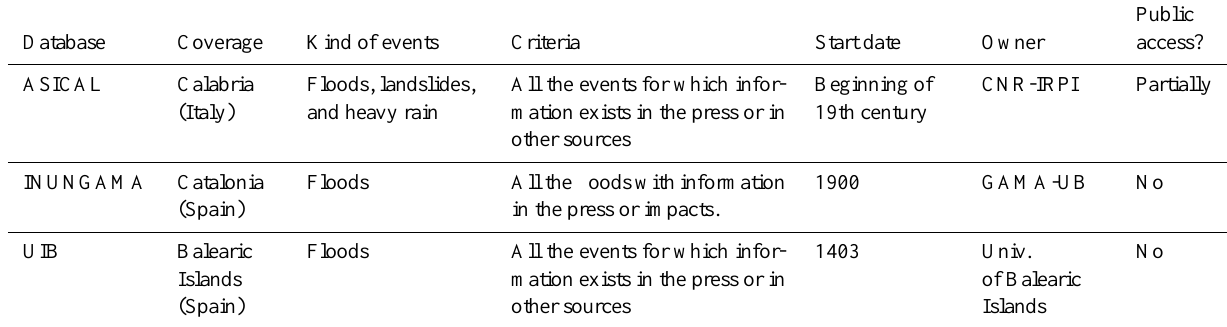
Table 4. Regional databases on flood events, for some regions of Italy and